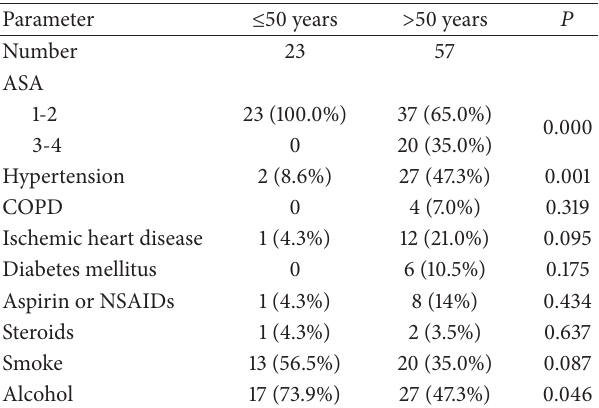
Table 2: Patients’ comorbidities and